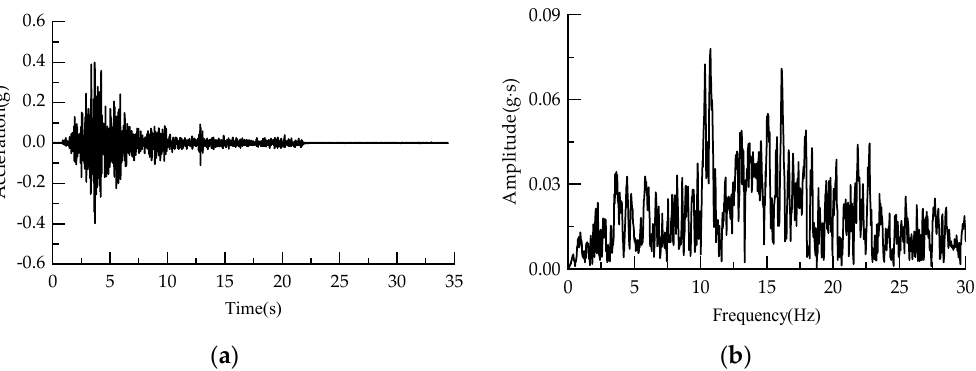
Figure 12. Input earthquake wave. ( a ) Acceleration time histories; ( b ) Fourier spectra.